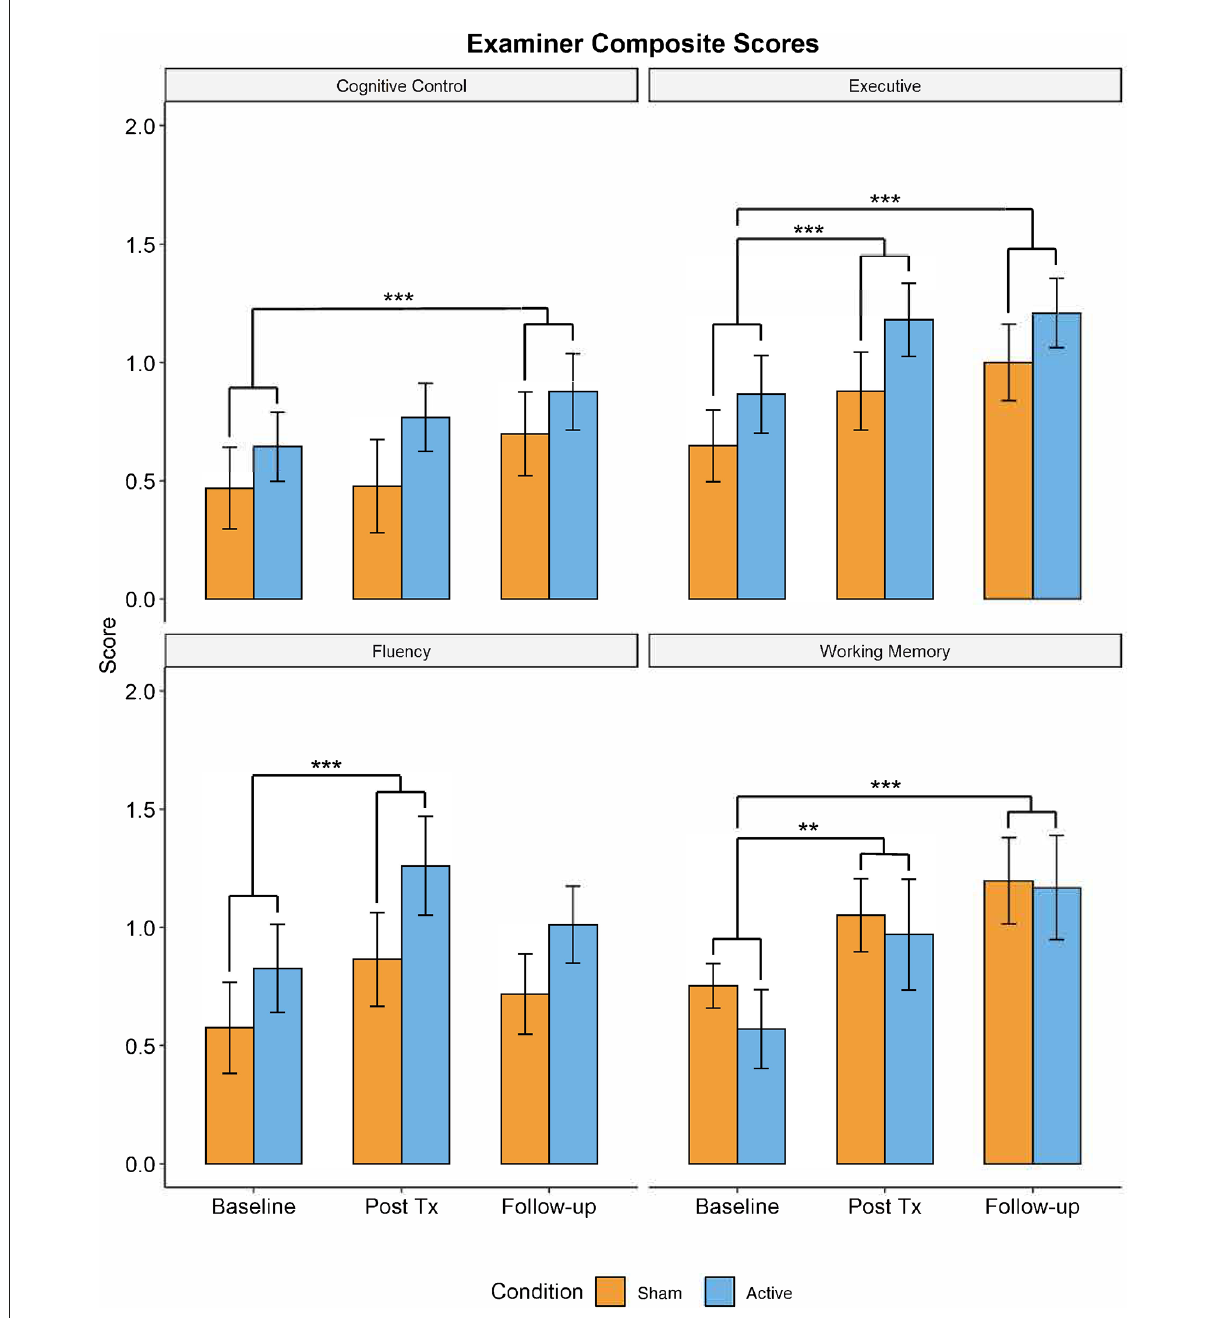
FIGURE4 Performance in trained domains of executive function (i.e., EXAMINER Cognitive Control, Working Memory, and Executive composites) demonstratedsignificantimprovementsfrombaselinevisitto1-monthfollow-up(** p < 0.01,*** p < 0.005).Therewerenosignificantdifferences in performance between active and control groups. Blue = active group. Orange = control group.